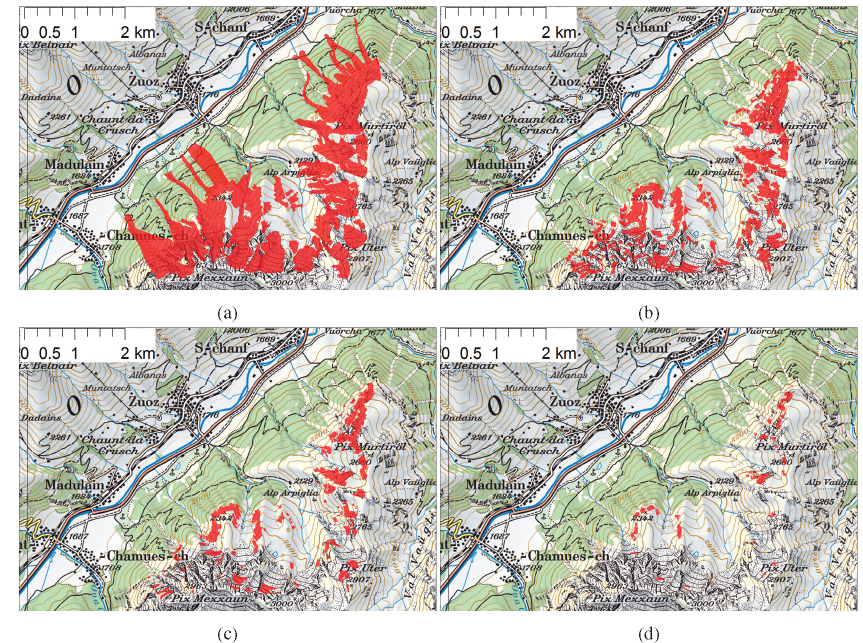
Figure 9. Maps of observed avalanches within 30 years of observation south of Zuoz showing in red (a) the entire avalanche perimeter of all avalanches, (b) the extracted release areas of all avalanches, (c) the extracted avalanche release area that released avalanches at least twice and (d) the extracted avalanche release area that released avalanches at least five times.